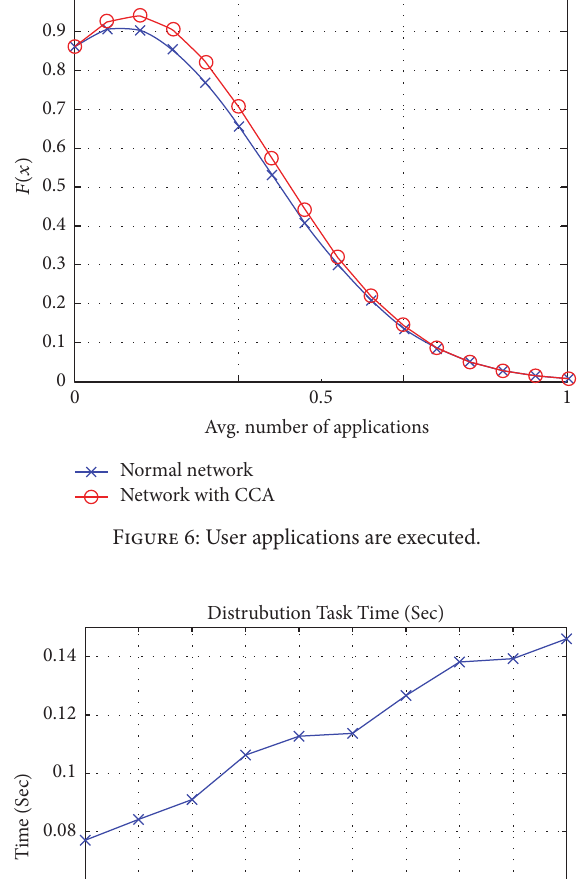
Figure 7: Distribution